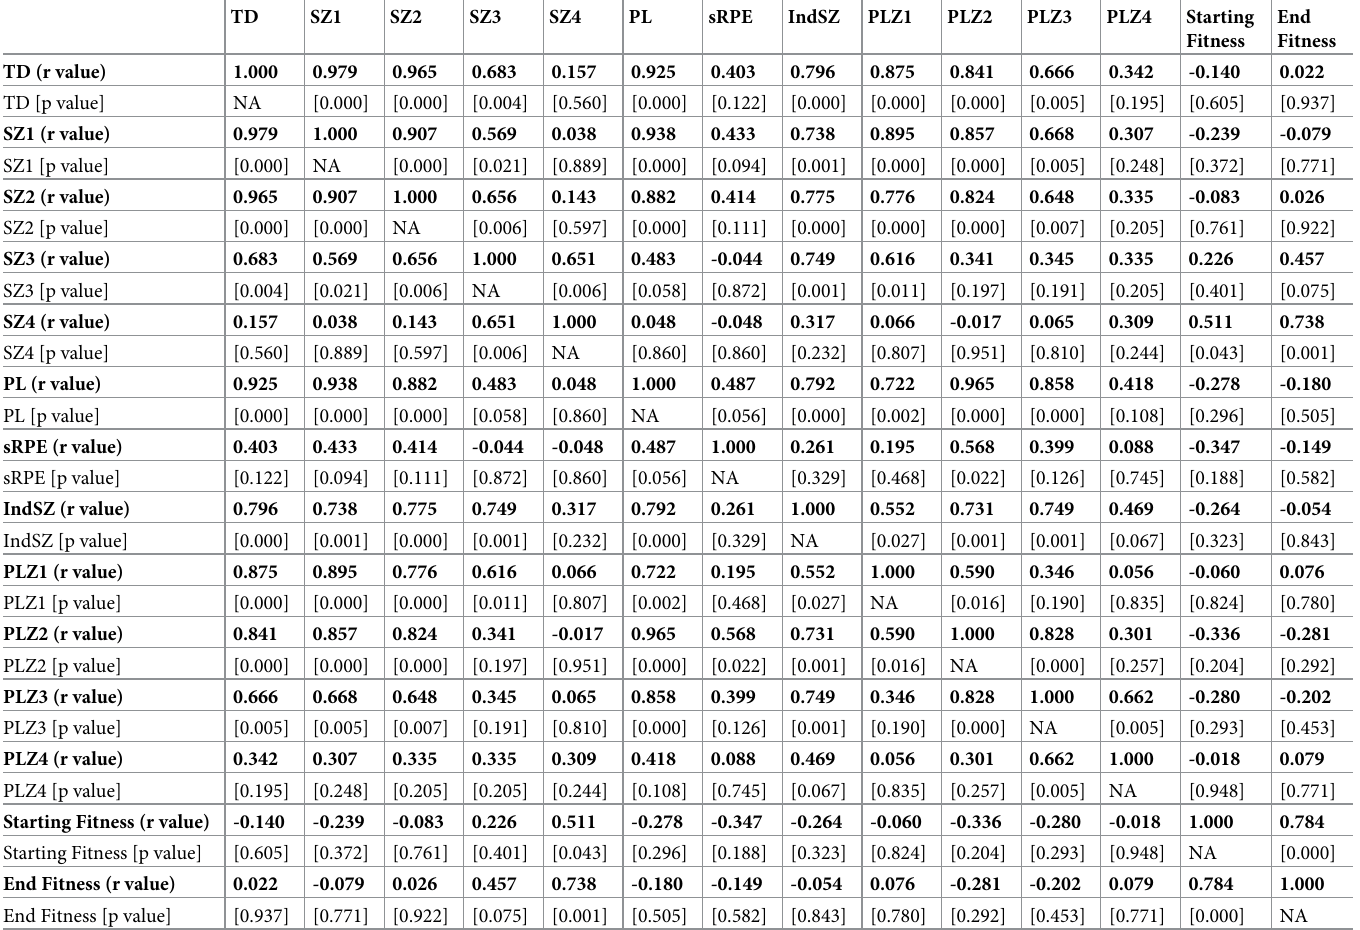
Table 3. Results of the Pearson correlation analysis between training load variables, starting fitness and end